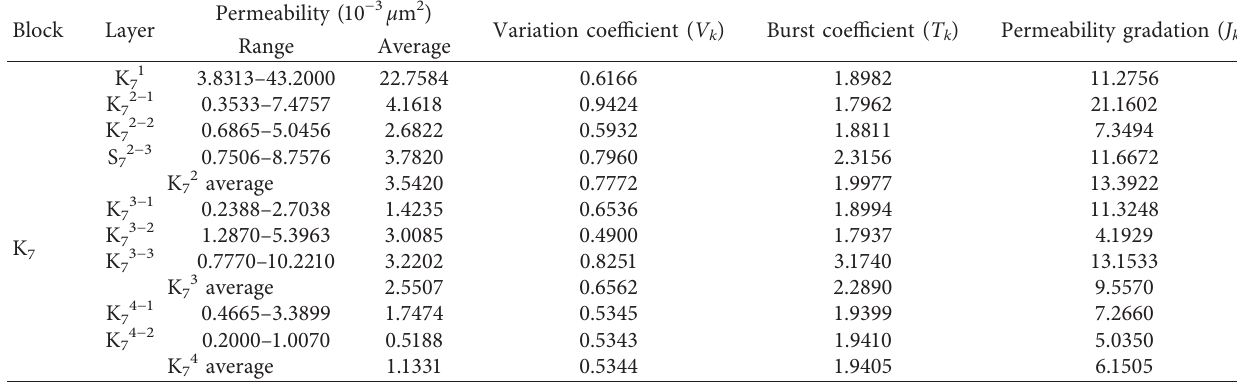
Table 1: The permeability heterogeneity parameters of each sublayer of the K